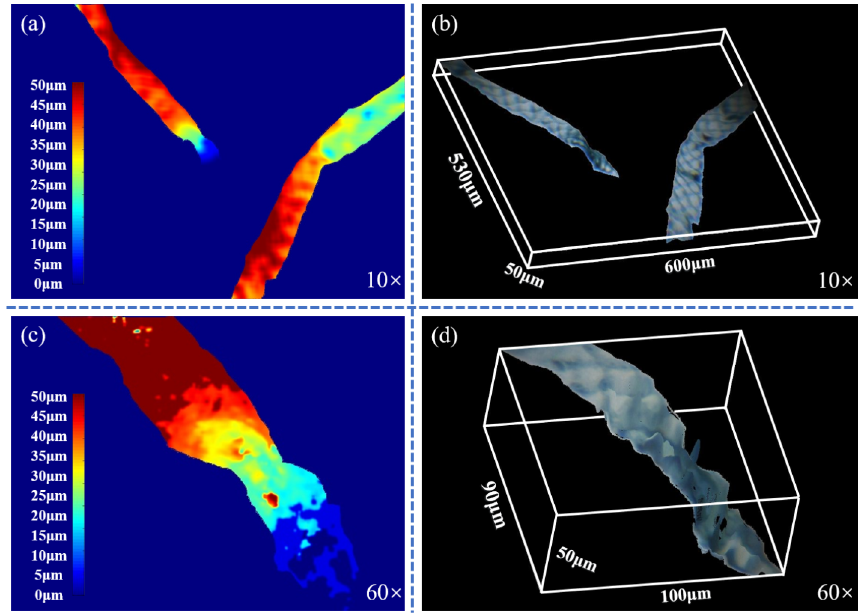
(e) Three-dimensional view map at the magnification of 60 ×